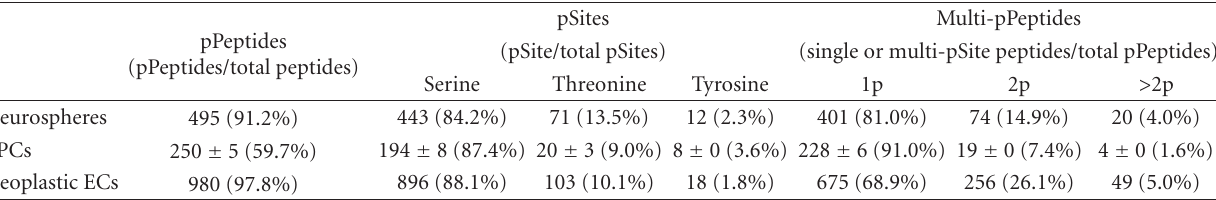
Table 1: Protein phosphorylation of adult CNS stem/progenitor cells, EPCs, and neoplastic ECs.